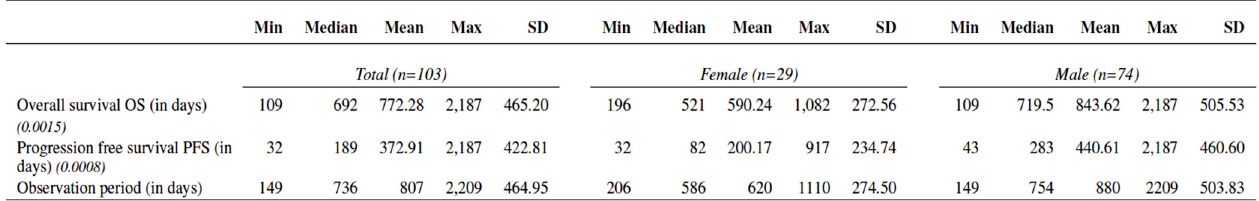
Figure 7. Overall survival OS and progression free survival PFS of female and male patients with advanced melanoma treated with ICI.